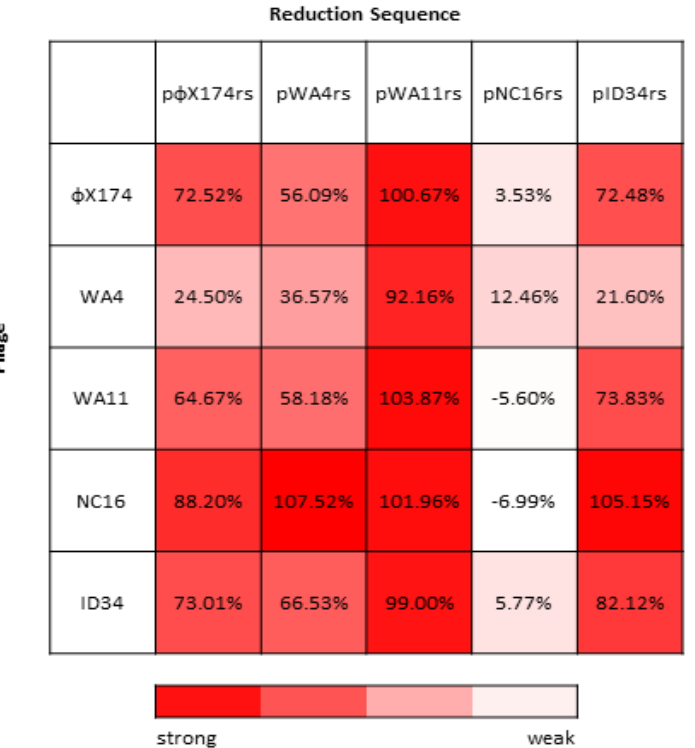
Figure 4. Percent inhibition (calculated as described in Methods) for all assayed phages grown in the presence of each reduction sequence. Least inhibited phage–reduction sequence pairings are shown in white, while the most inhibited phage–reduction sequence pairings are shown in red.